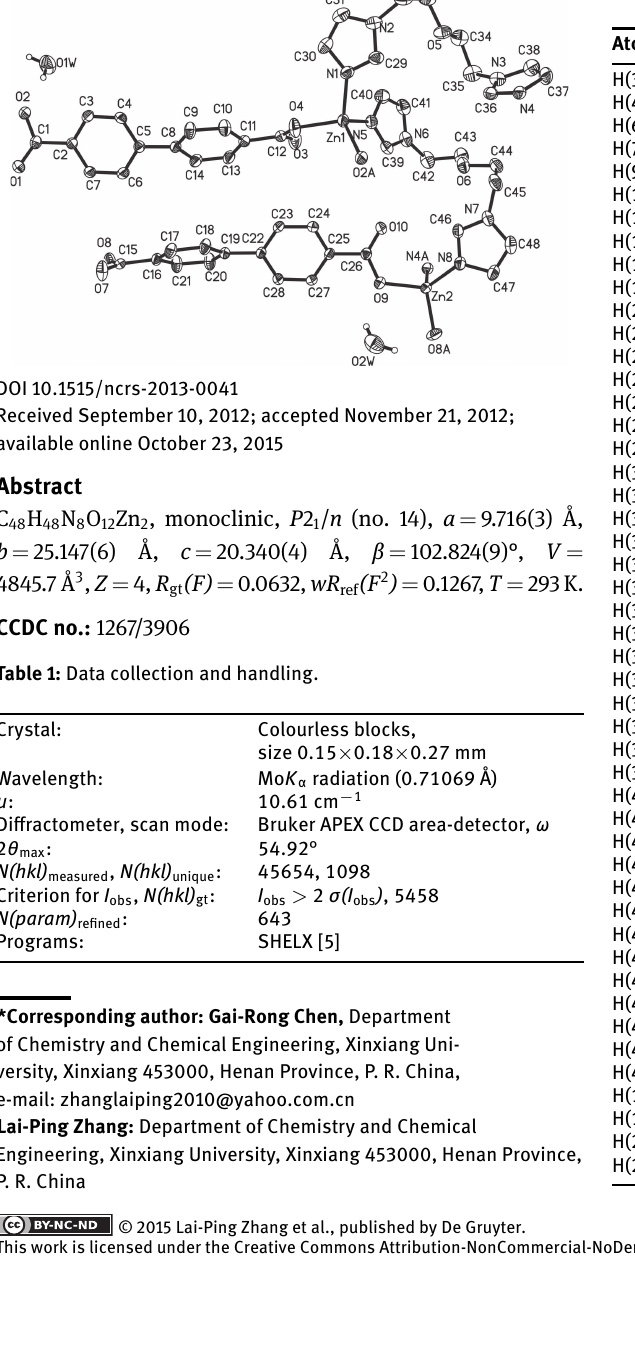
Table 2: Atomic coordinates and displacement parameters (in Å 2